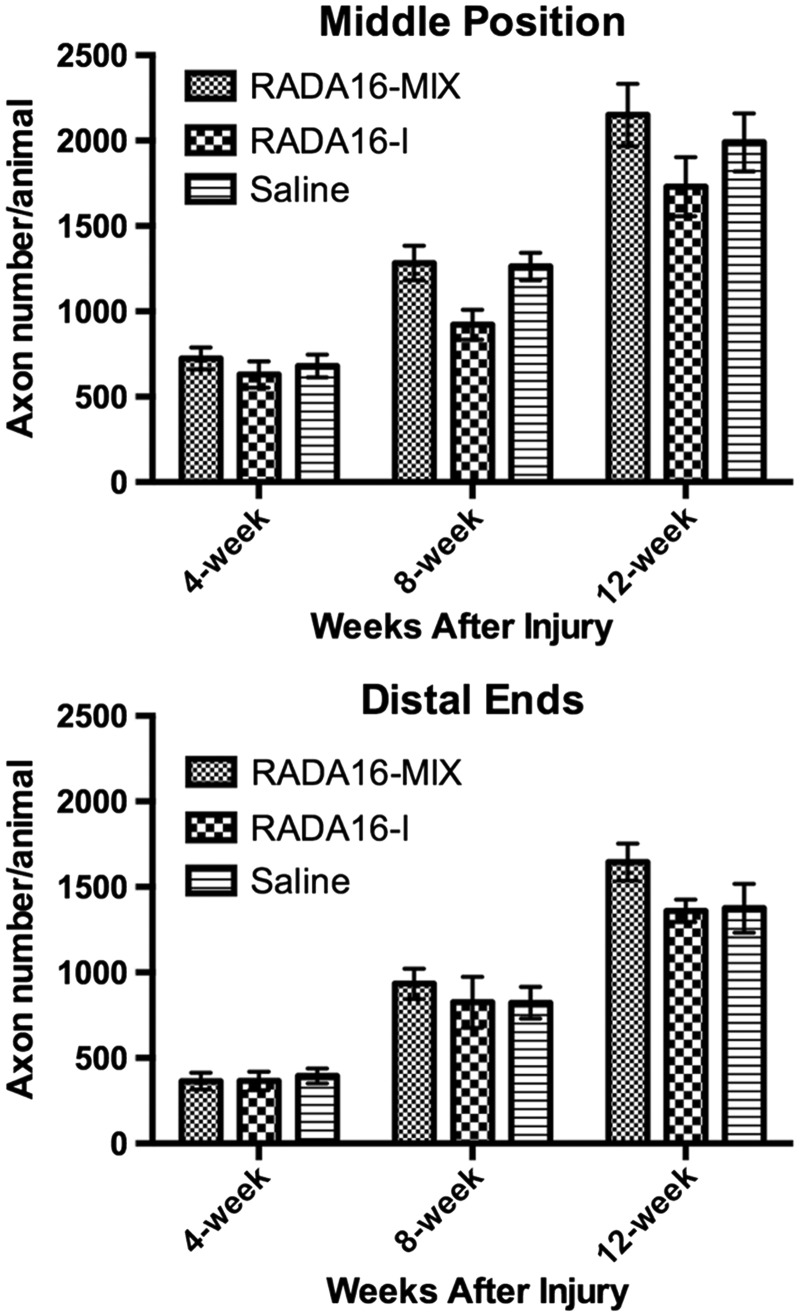
The axon numbers at the midpoints and distal planes after different transplantation time (one-way ANOVA test and Tukey’s multiple comparisons test; P > 0.05).